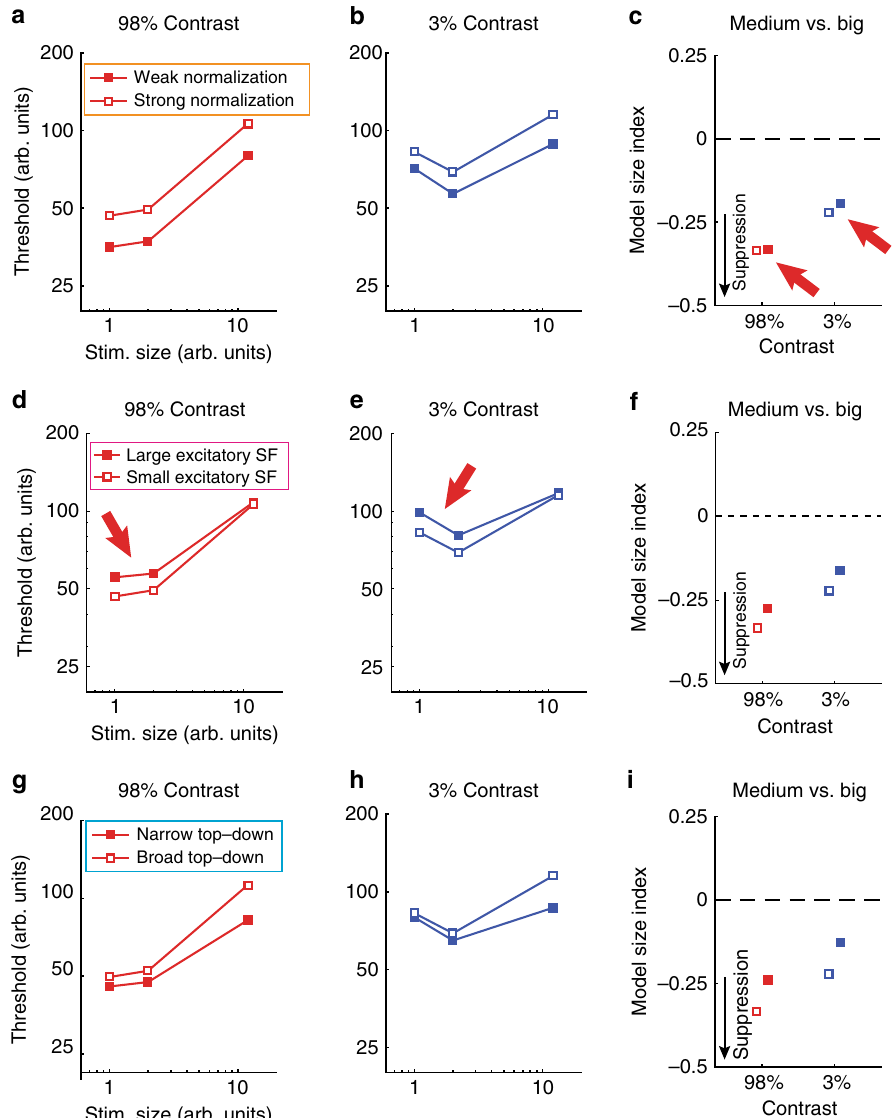
Fig. 5 Normalization model results. We used a divisive normalization model to describe motion duration thresholds, as in our previous work 12 . a , b Weaker normalization (25% weaker suppressive gain 2 ) yields lower predicted duration thresholds across stimulus sizes and contrasts. c Size indices are not dramatically altered by weaker normalization. More negative values indicate stronger suppression (black arrow). Red arrows indicate a poor